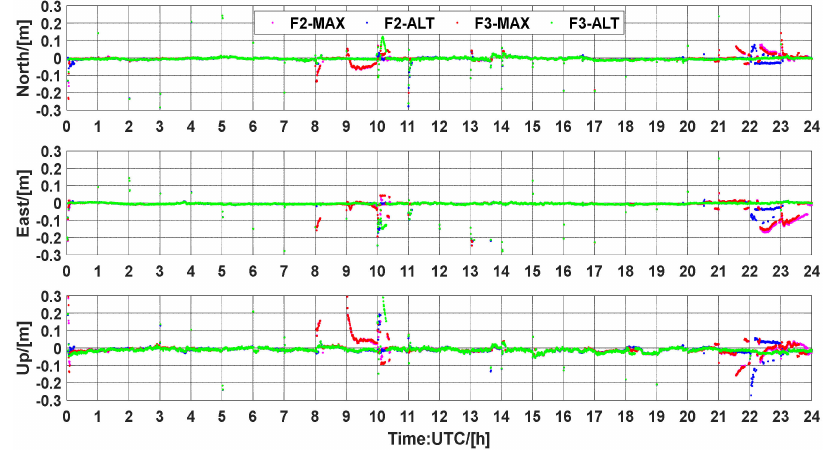
Figure 19. Position errors for UCPPP PAR using the atmospheric corrections from BRUX station on DOY 083,